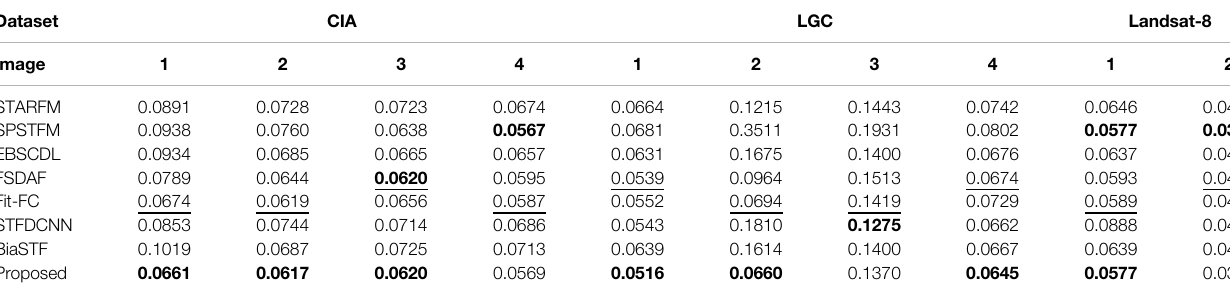
TABLE 8 | SAM evaluation of spectral inconsistency. Dataset